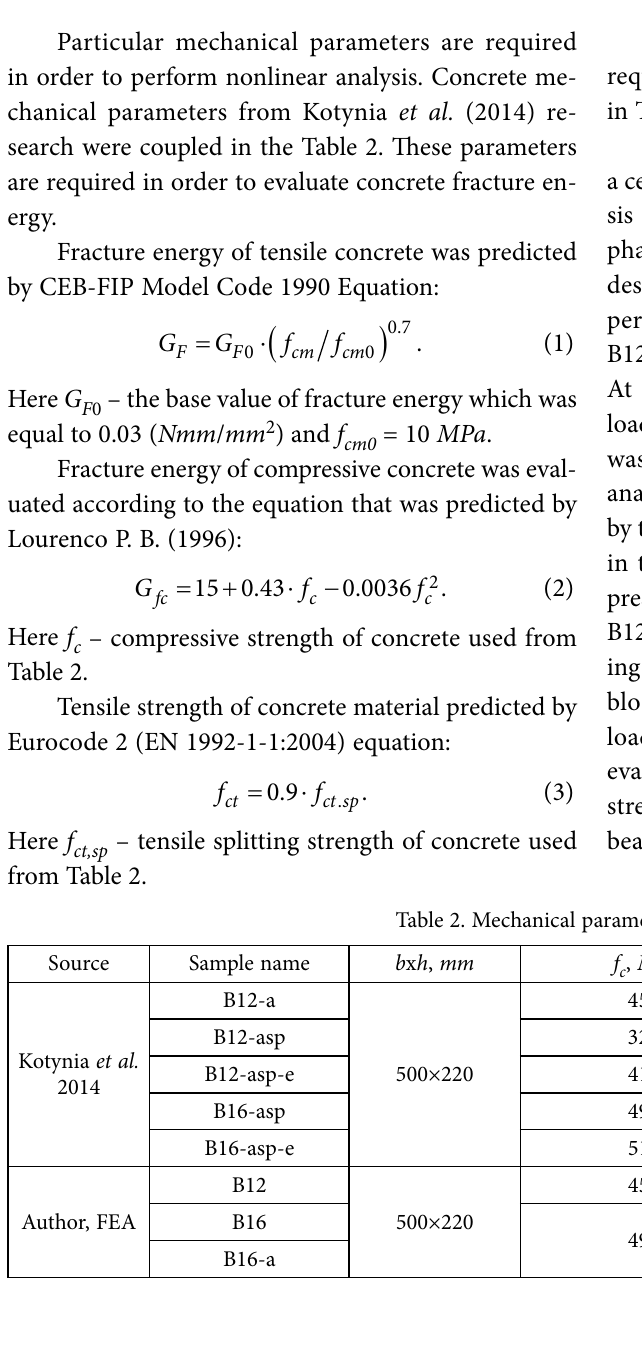
Fig. 1. FEA models of analyzed beams: a – internal and external reinforcement; b – loading